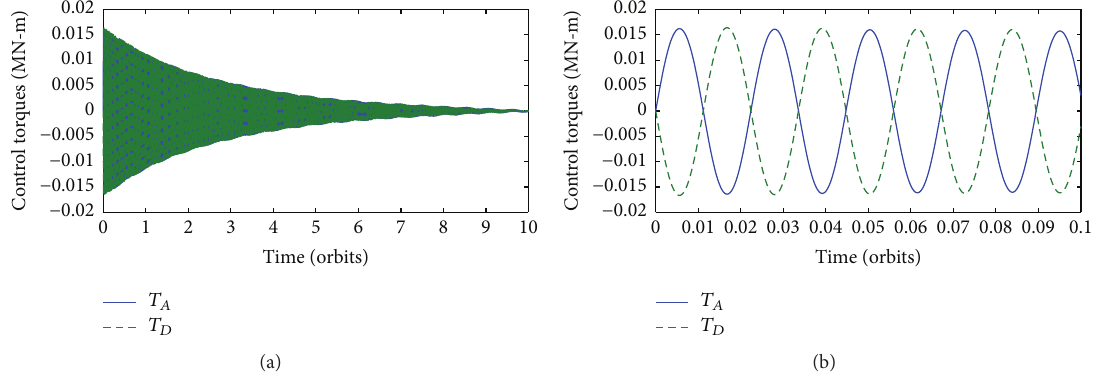
Figure 17: Control torques from the formulations based on point 𝐴 by applying the SDRE control with 𝛼 = 0 for (a) the first 10 orbits and (b) the first 0.1